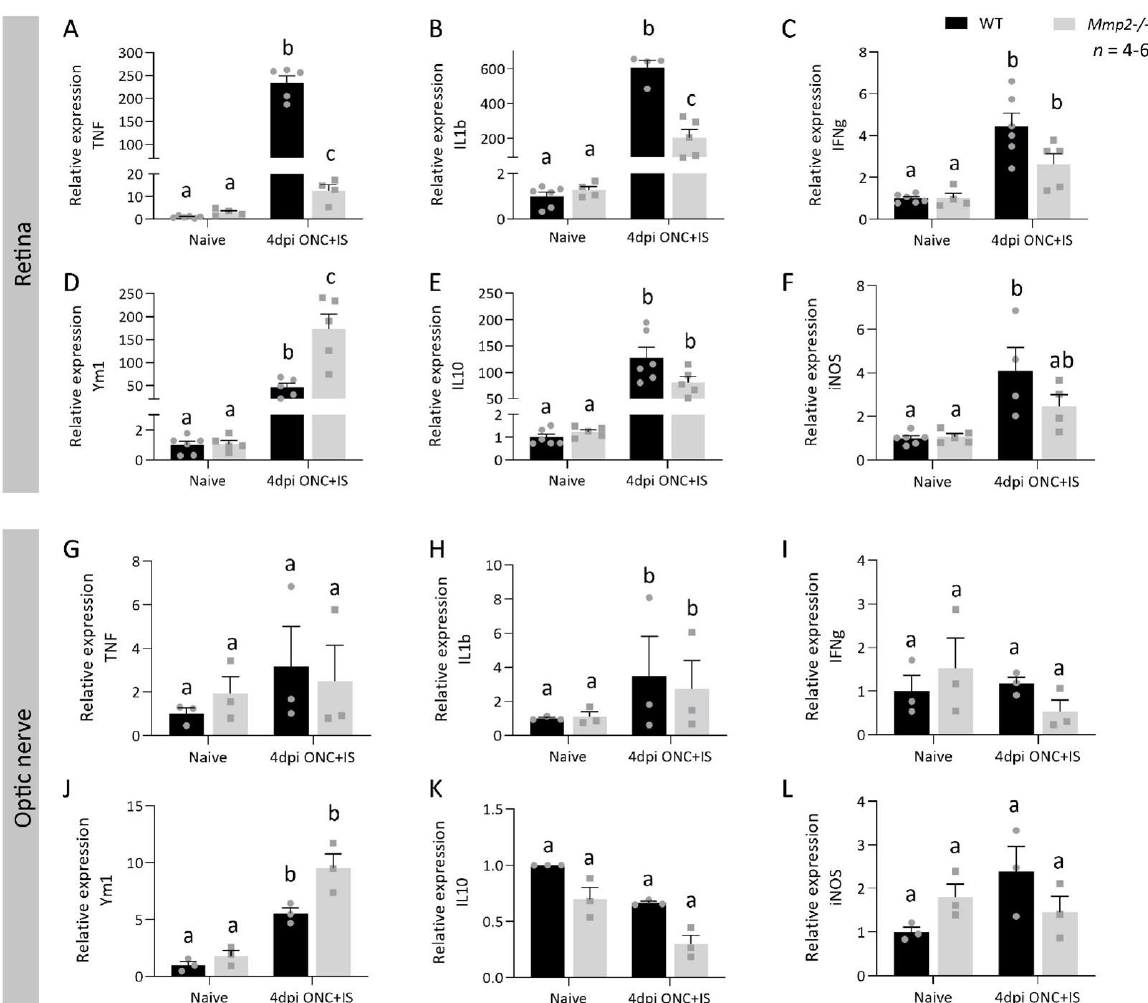
Figure 7. MMP2 deficiency affects the expression profile of pro- and anti-inflammatory cytokines in the retina and optic nerve after ONC injury combined with an inflammatory stimulation. qRT-PCR data showed the expression of pro- ( A – C , G – I ) and anti-inflammatory cytokines ( D – F , J – L ) at 4 dpi ONC+IS in retinas ( A – F ) and optic nerves ( G – L ) of both WT mice and Mmp2 -/- mice. Data are relative expression values compared to the expression value in naive WT retinas or optic nerves (fold change) and presented as mean ± SEM. Repeated measures two-way ANOVA for qRT-PCR analysis followed by Tukey’s multiple comparisons test. Statistical significance between different time points is indicated using different